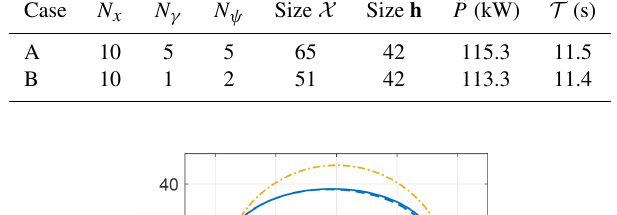
Figure 33. Optimal ψ as a function of the angular position.